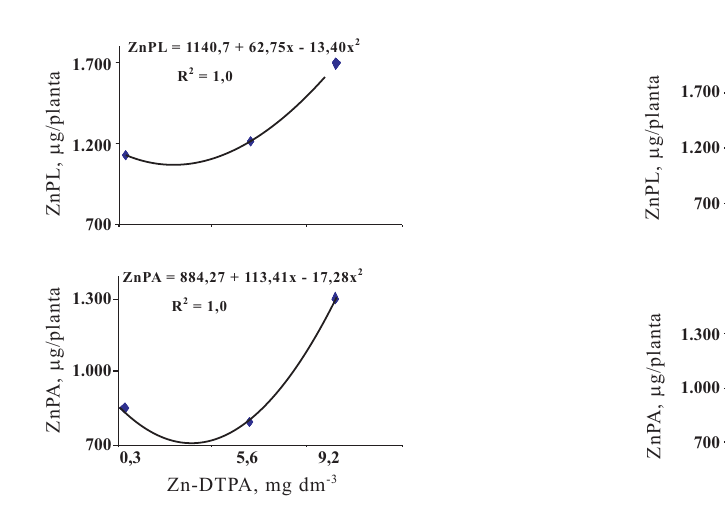
Figura 5. Conteúdo de Zn na planta inteira (Zn–PL) ou na parte aérea (Zn–PA) em função do teor disponível no solo pelo extrator DTPA, nas plantas enxertadas